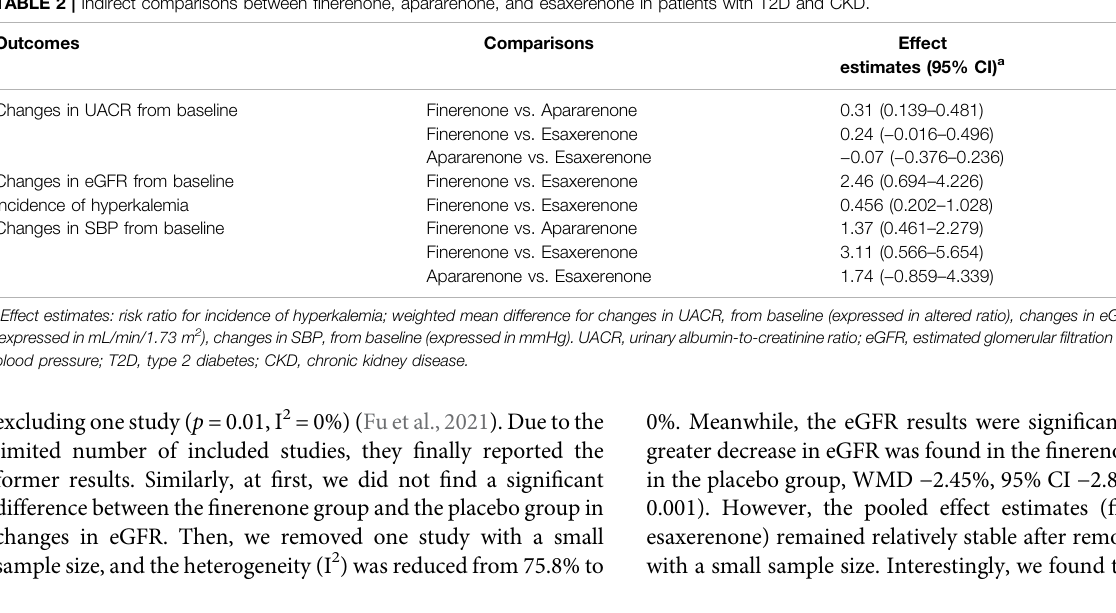
TABLE 2 | Indirect comparisons between fi nerenone, apararenone, and esaxerenone in patients with T2D and CKD. Outcomes Comparisons Effect Changes in UACR from